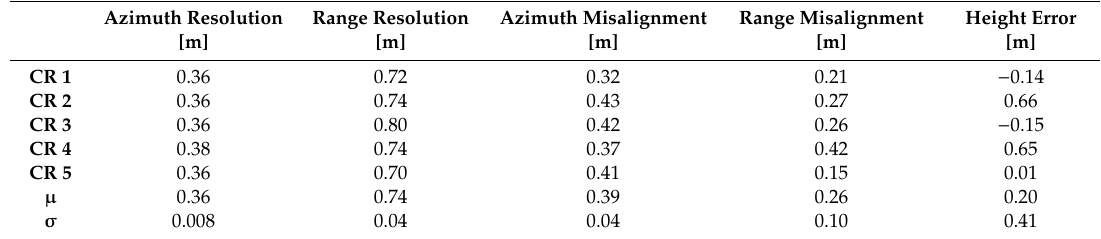
Table 6. Measurements on